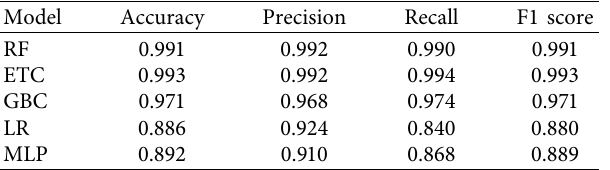
Table 10: Results of machine learning models with SMOTE data resampling. Model